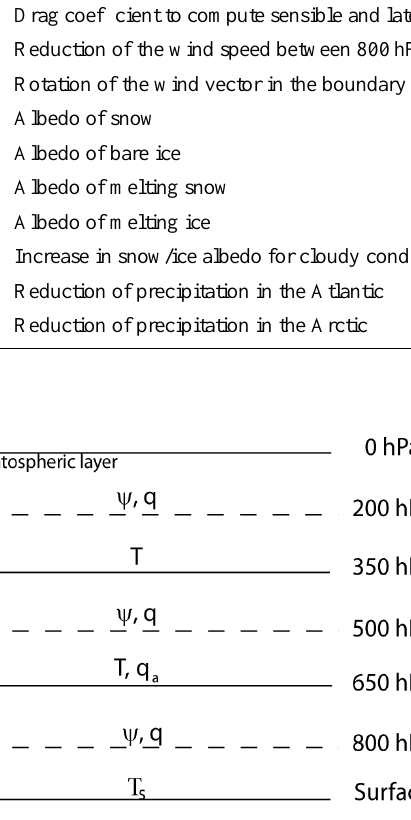
Fig. 2. Vertical discretization of the atmospheric model ECBilt. Ψ is the streamfunction, q is the quasi-geostrophic potential vorticity, T is the air temperature, T s is the surface temperature and q a is the total water content.